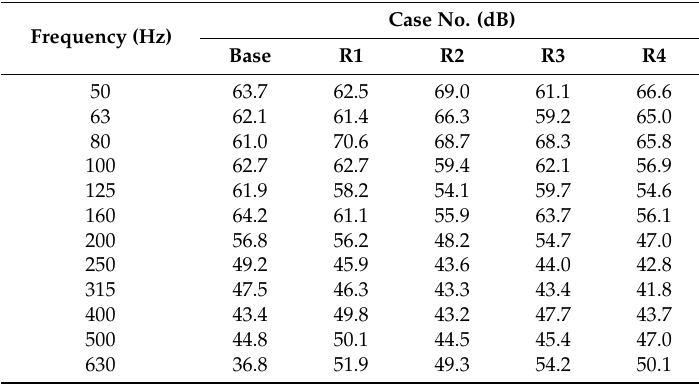
Table 13. Impact ball’s test results in 1/3 Octave bands.